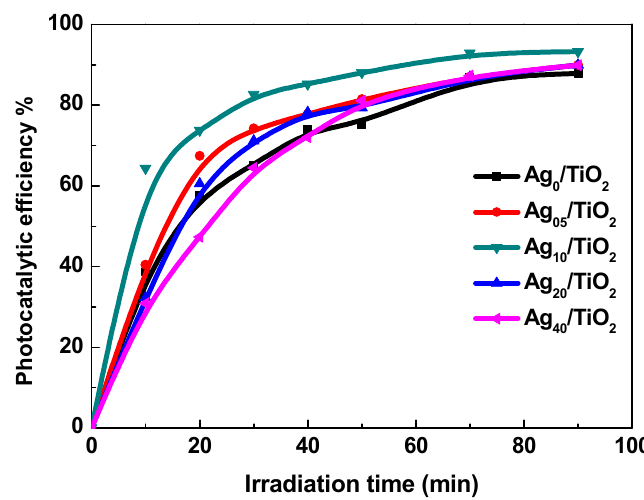
Figure 8. Photocatalytic efficiency toward methylene blue (MB) versus time of Ag x /TiO 2 , where x = 0, 5, 10, 20, and 40.